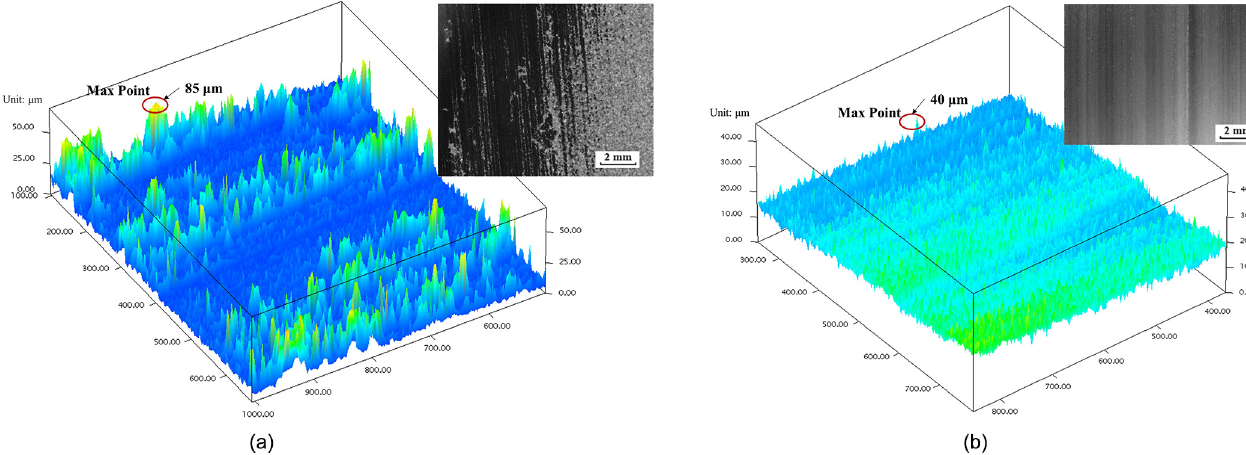
Fig. 10. The testing result of 3D surface topography: (a) Effect before improvement and (b) effect